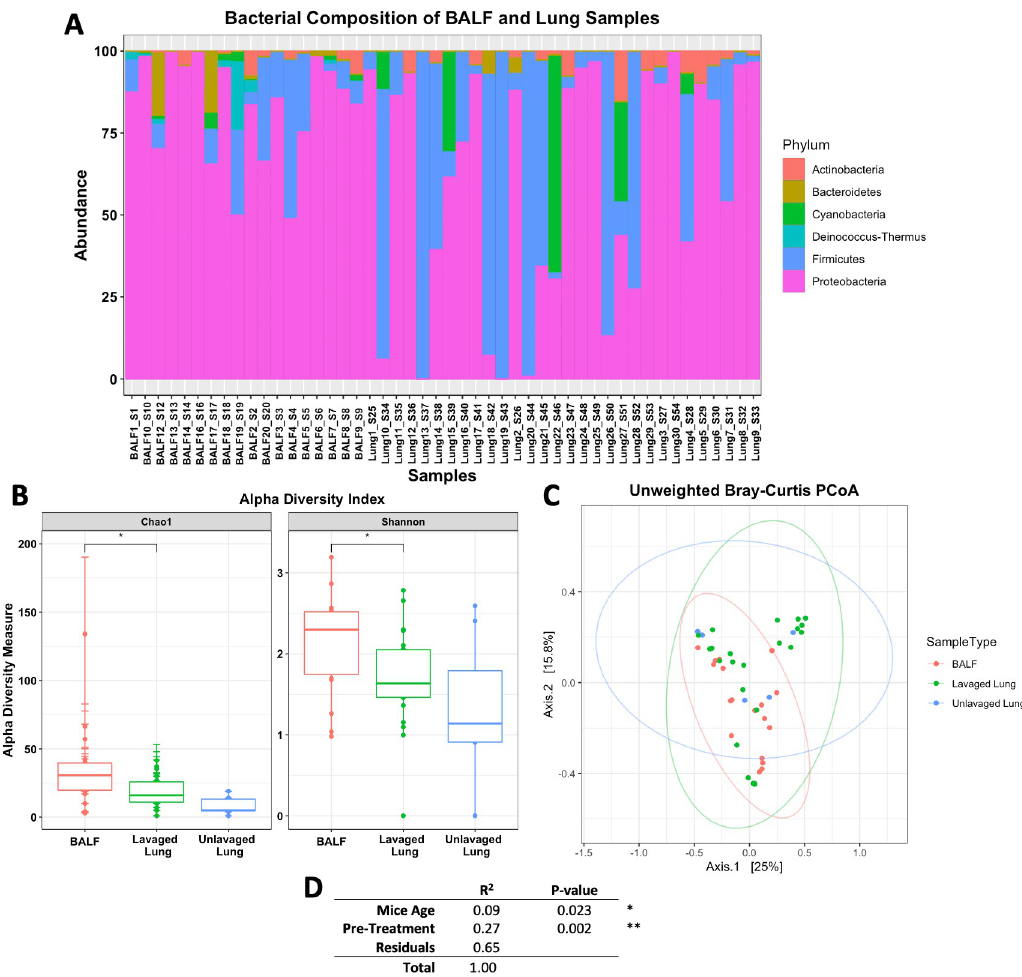
Fig 4. Diversity analysis of BALF and lung tissue samples. A) Bacterial composition of lung and BALF samples. Overall, samples had a higher abundance of Proteobacteria and Firmicutes bacteria. B) Alpha diversity measures shows that BALF samples have a higher species richness compared to both lavaged and unlavaged lung samples. Observed significant (p < 0.05) difference in species richness between BALF and lavaged lung samples. C) Beta diversity plot shows admixture of sample types. D) Statistical summary of ADONIS test shows the variance and significance when comparing mice age and extraction pre- treatment